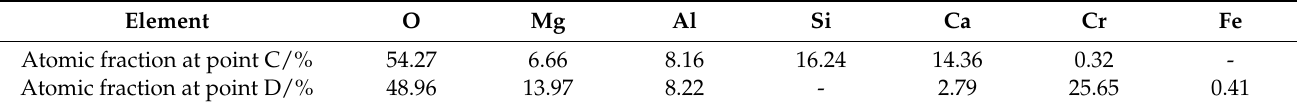
Table 3. Element composition and atomic fraction of points C and